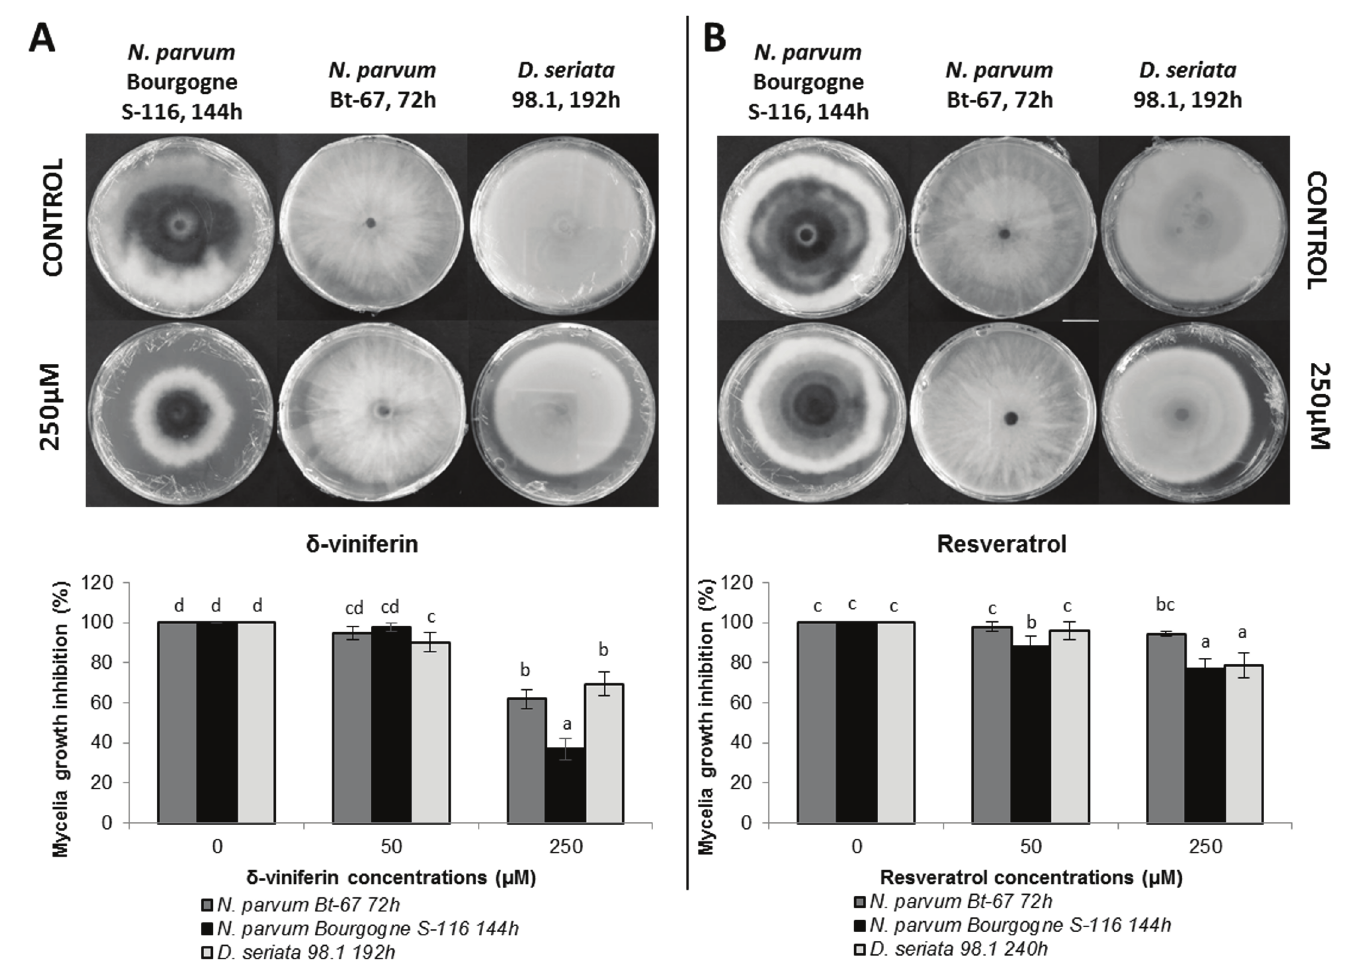
Fig 5. Comparison of the effect of δ -viniferin and resveratrol on Botryosphaeriaceae . Effect of δ -viniferin (A) and resveratrol (B) on mycelialgrowth of N . parvum BourgogneS-116, N . parvum Bt-67 and D . seriata 98.1. Pictures were taken at different time points, when the fungi have nearly colonizedall the Petri dish for control conditions (one day before saturation). Values are means and SD of two biologicalreplicates, each calculatedfrom the mean of three technicalreplicates. Means with a same letter are not significantly different at p (cid:20) 0.05(Tukey Contrasts).